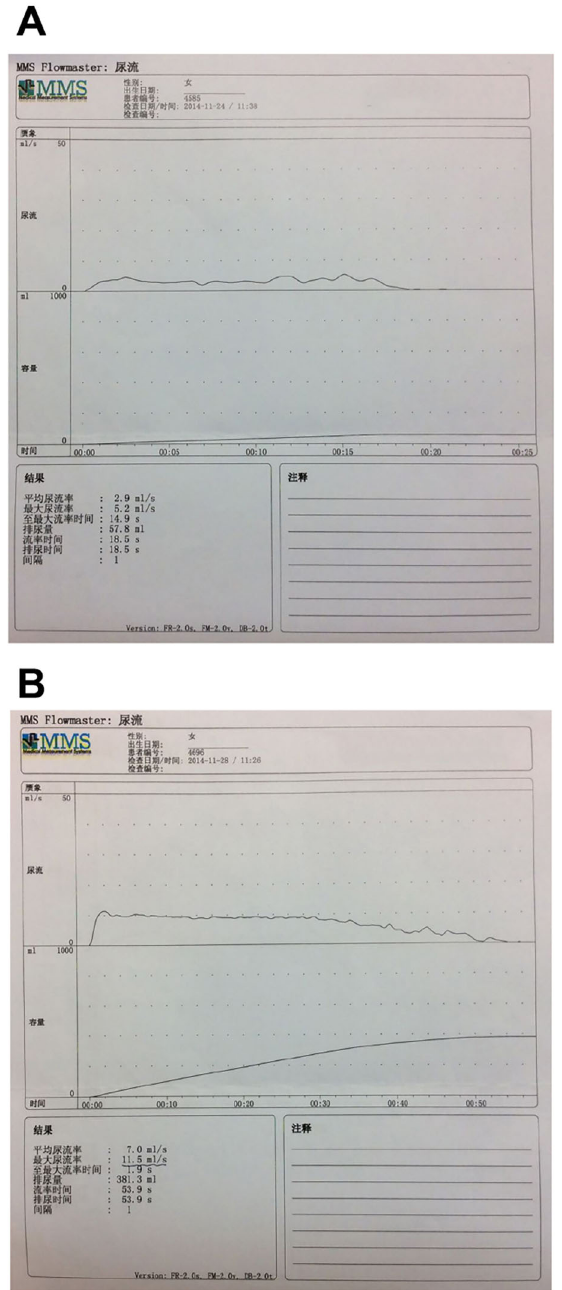
Figure 6. Measurement of urine fl ow rate. A , A maximum urine fl ow rate of 5.2 mL/s was measured before treatment with urethral dilatation and oral cyclosporine A. B , A maximum urine fl ow rate of 11.5 mL/s was measured after treatment with urethral dilatation and oral cyclosporine